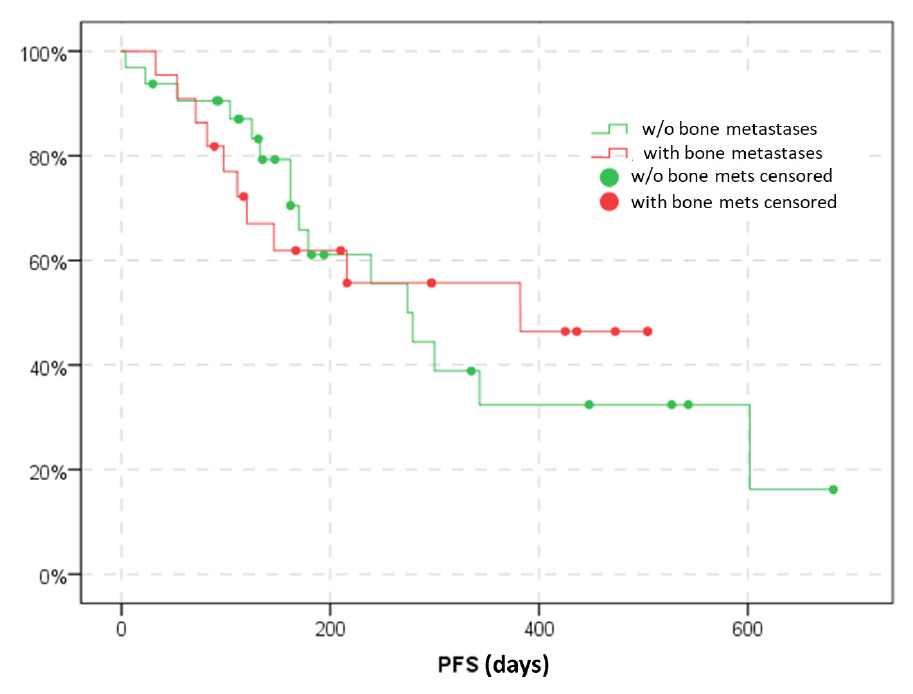
Fig. 3. Progression-free survival of patients with and without (w/o) bone